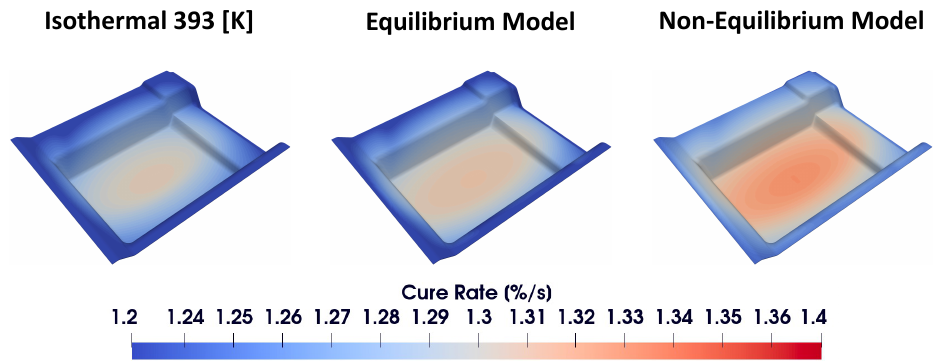
Figure 10. Predicted cure rate distribution at 10s into the curing stage using different energy mod- elling